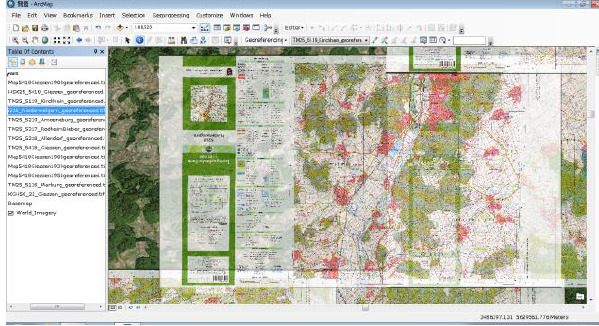
Figure 22. Map of Niederwalgern: